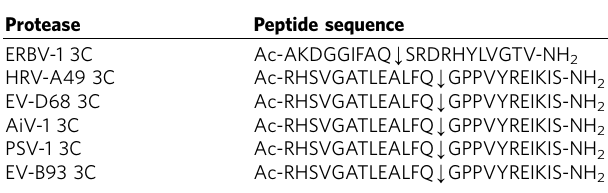
Table 3 | Peptide sequences used for testing inhibitory activity of 3C proteases.